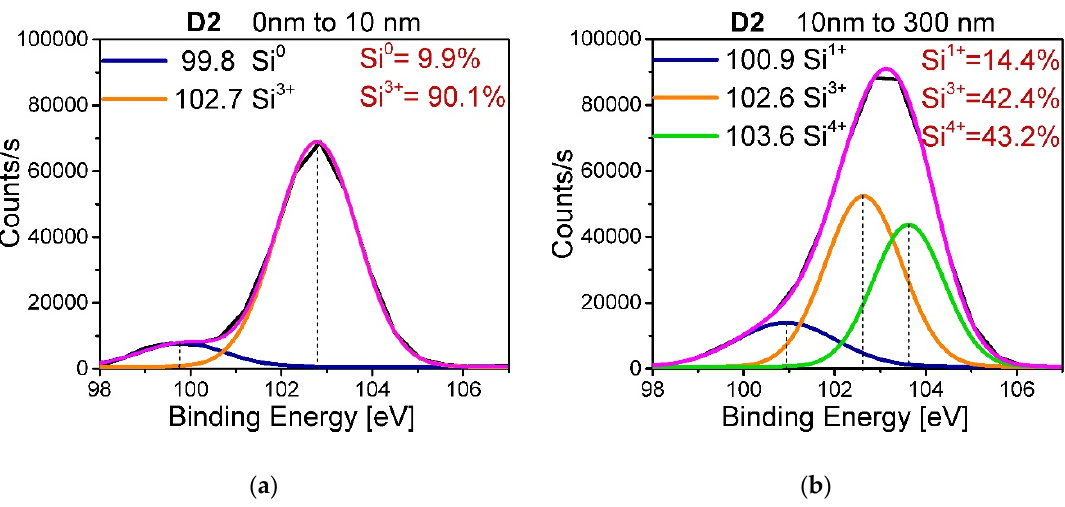
Table 5. Binding energies of the decomposed XPS peaks.